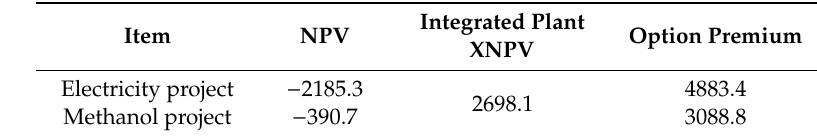
Table 2. Values of projects considered—net present values (NPVs) of methanol and electricity technologies and ‘expanded NPVs’ (XNPVs) of the integrated plant with option premiums (million PLN, year “0”) (source: own